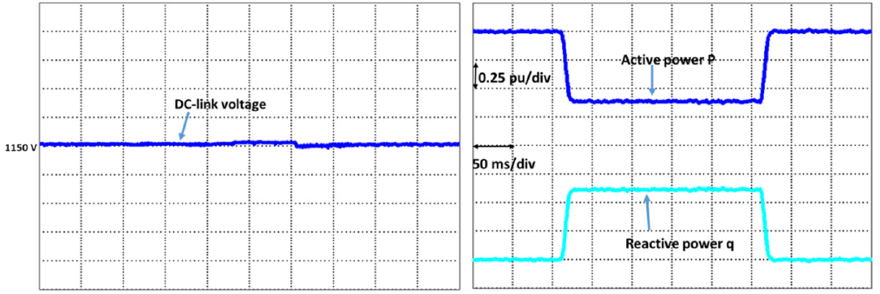
Figure 19. DC-link voLtage and Power regulation.